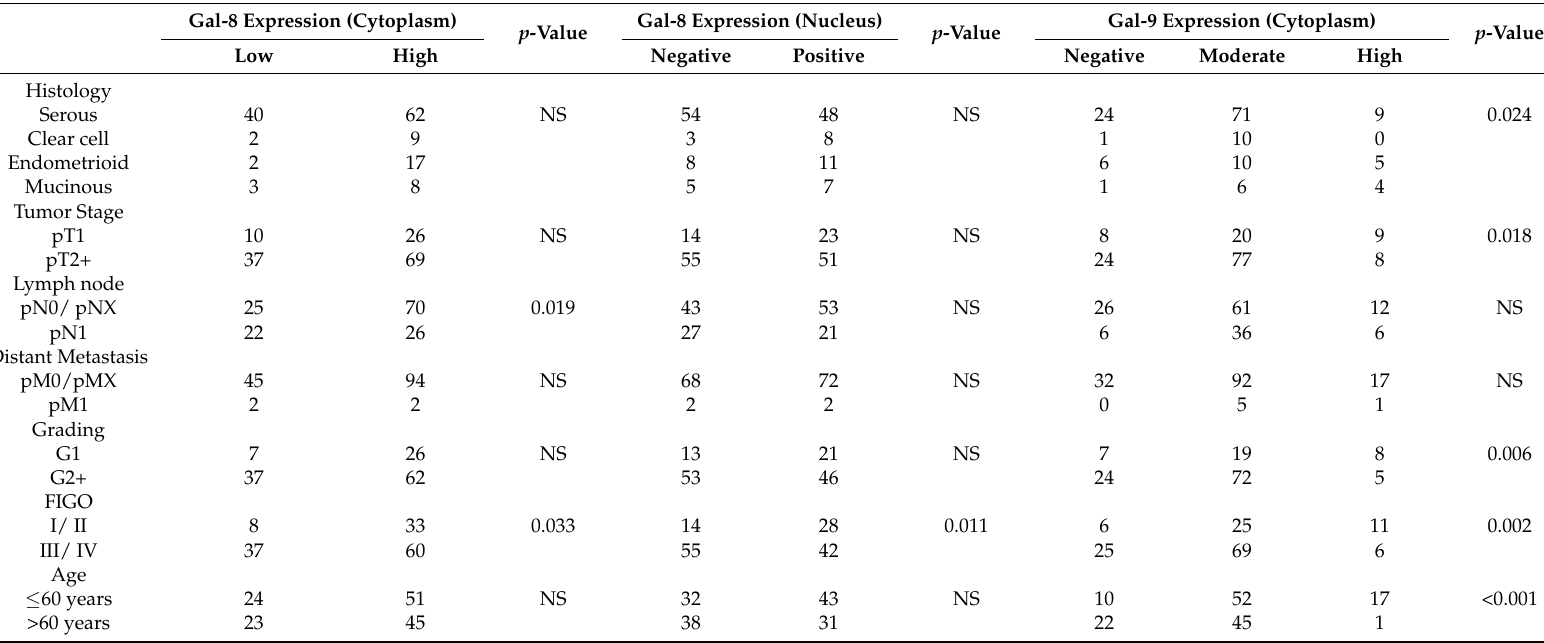
Table 1. Gal-8 and -9 staining correlated with clinical and pathological